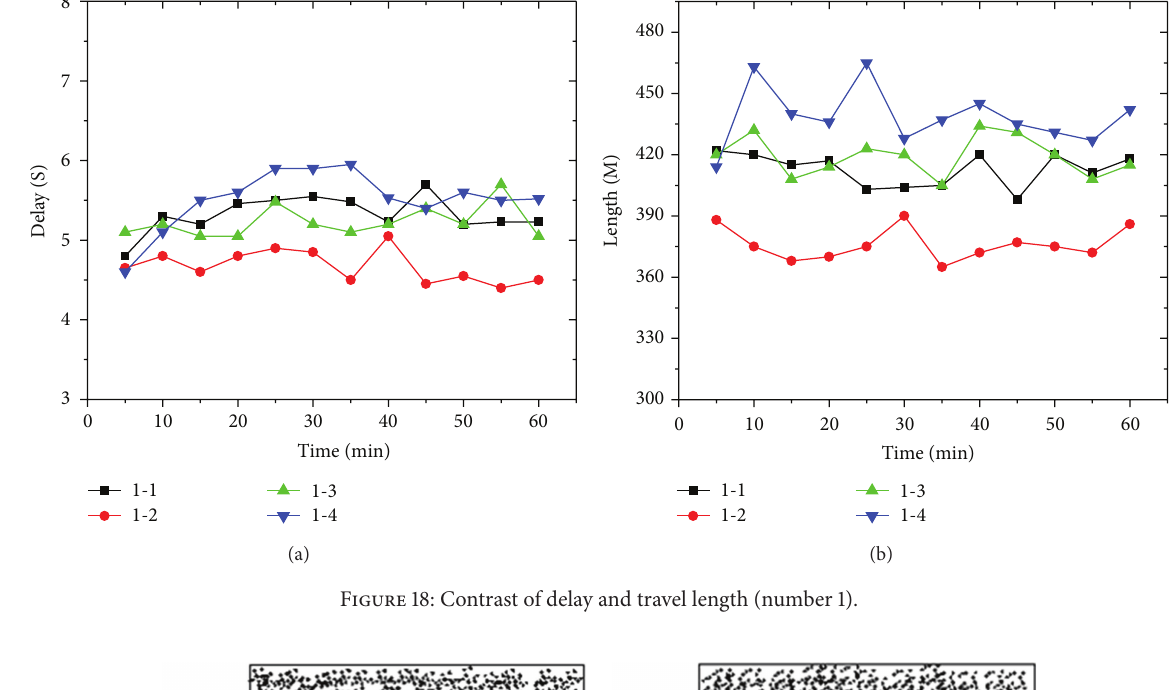
Figure 18: Contrast of delay and travel length (number 1).